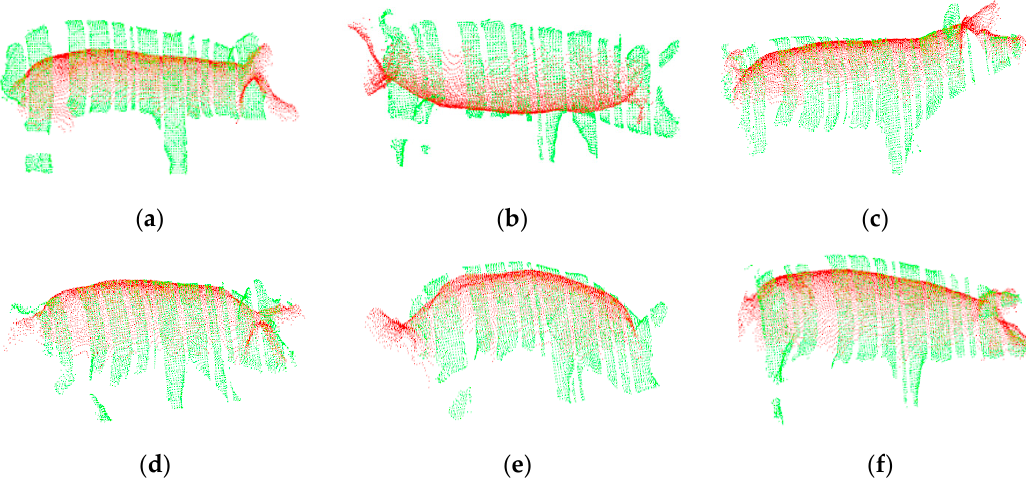
Figure 8. Registration results of the traditional point cloud registration method: ( a ) Large White pig in a standing pose; ( b ) Large White pig in a walking pose; ( c ) Large White pig in an upward-looking pose; ( d ) Large White pig in a bowing pose; ( e ) Large White pig with an arched back; ( f ) Landrace pig.